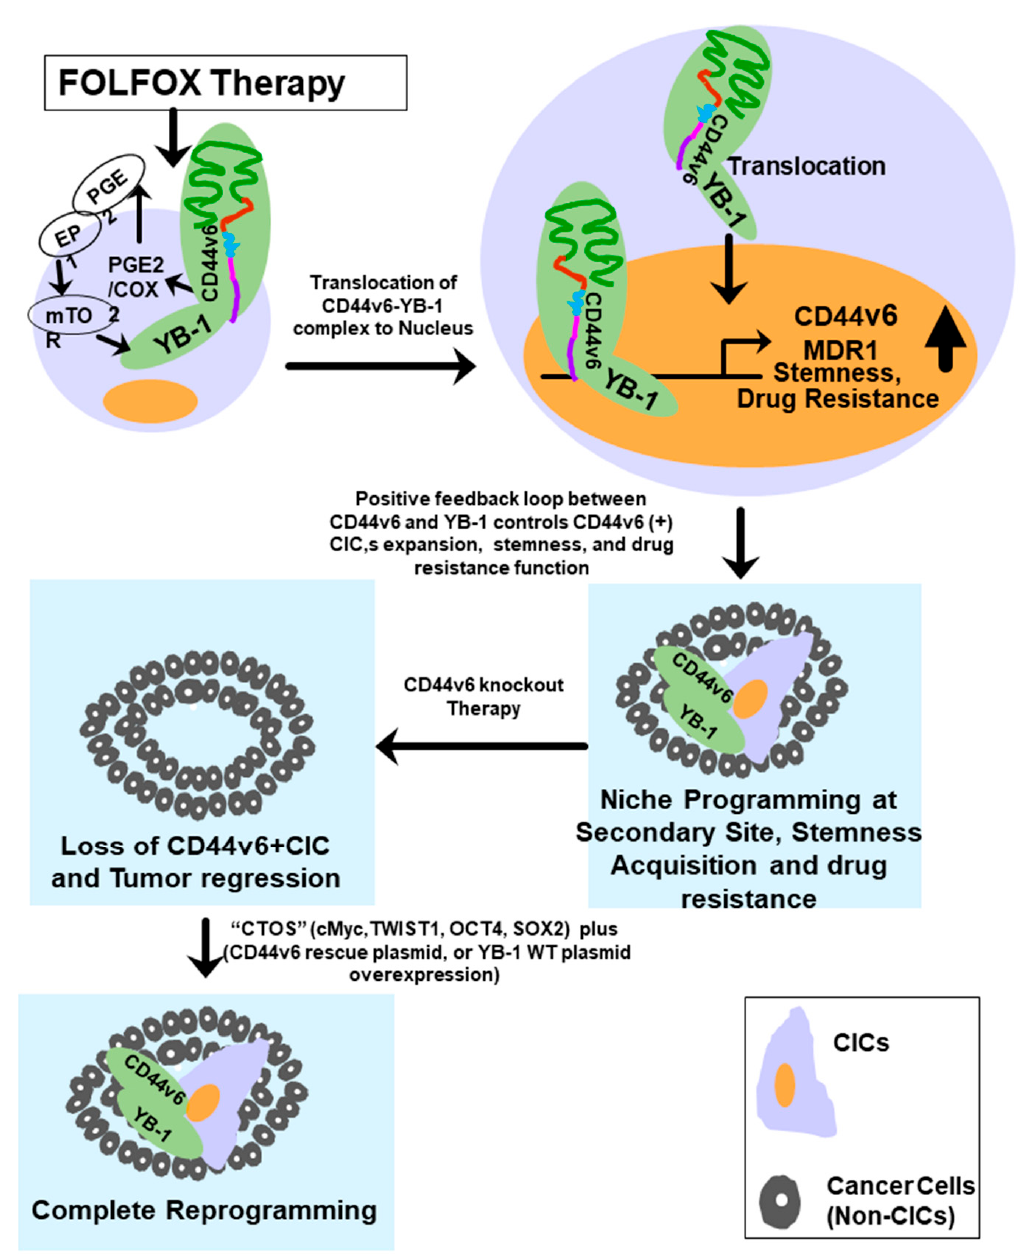
Figure 8. Proposed model for a positive feedback loop coupling YB-1 activation and CD44 alternate splicing and CD44v6 then sustains cancer initiating cell proliferation and stemness.